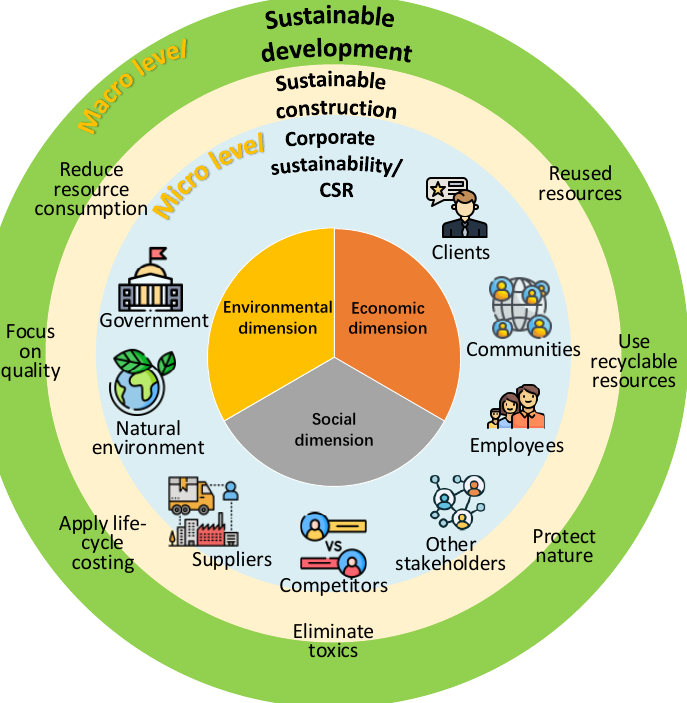
Figure 1. Relationships between sustainable development, sustainable construction, corporate sus- tainability, and corporate social responsibility (CSR).